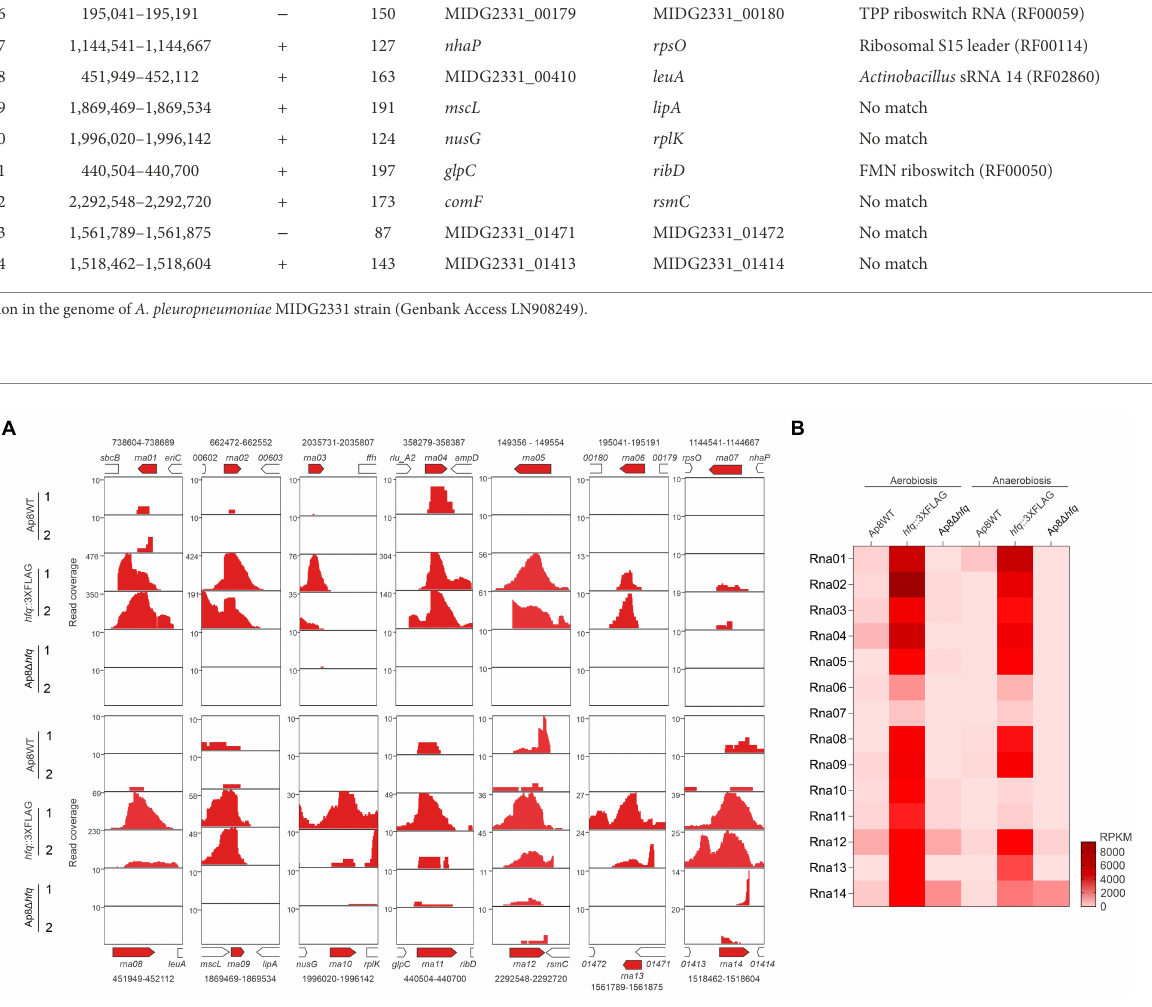
FIGURE 1 Identification of novel sRNA candidates associated with the chaperone Hfq. (A) Mapping regions of the RNA sequences from the WT, Ap8 hfq ::3XFLAG, and Ap8 Δ hfq strains showing increased intergenic reads in aerobiosis (1) and anaerobiosis (2), corresponding to the 14 sRNA candidates selected in this study. Genomic coordinates of the sRNAs are represented above ( rna01 to rna07 ) or below ( rna08 to rna14 ) of the open reading frames. (B) Heatmap showing the coverage, in reads per kilobase of transcript, per million mapped reads (RPKM), of the 14 putative novel sRNAs identified by